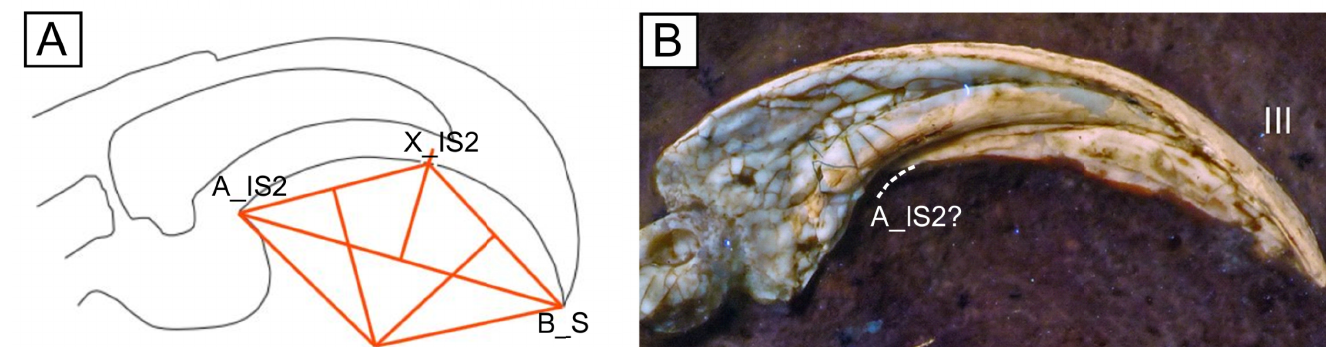
Fig 2. Alternative measure utilised for fossil claws and example Archaeopteryx claw. Claw drawn in Inkscape; measurements performed in DinoLino.exe. Landmark A_IS2 is located at the proximal termination of the ventral surface of the sheath. (A) A method of measuring claw angle after Fowler and colleagues [40], here denoted IS2. (B) Right pedal claw from the 12 th Archaeopteryx specimen [21]. Slight reconstruction was necessary for approximating